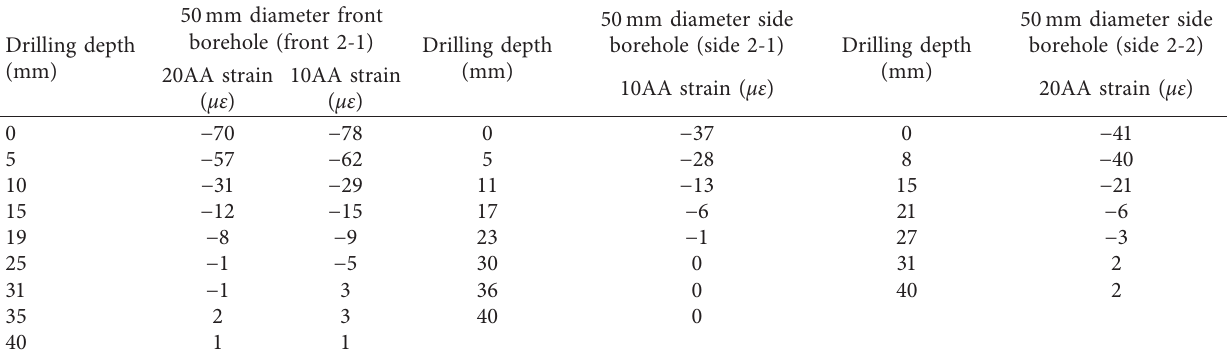
Table 4: Experimental measurements collected from the second